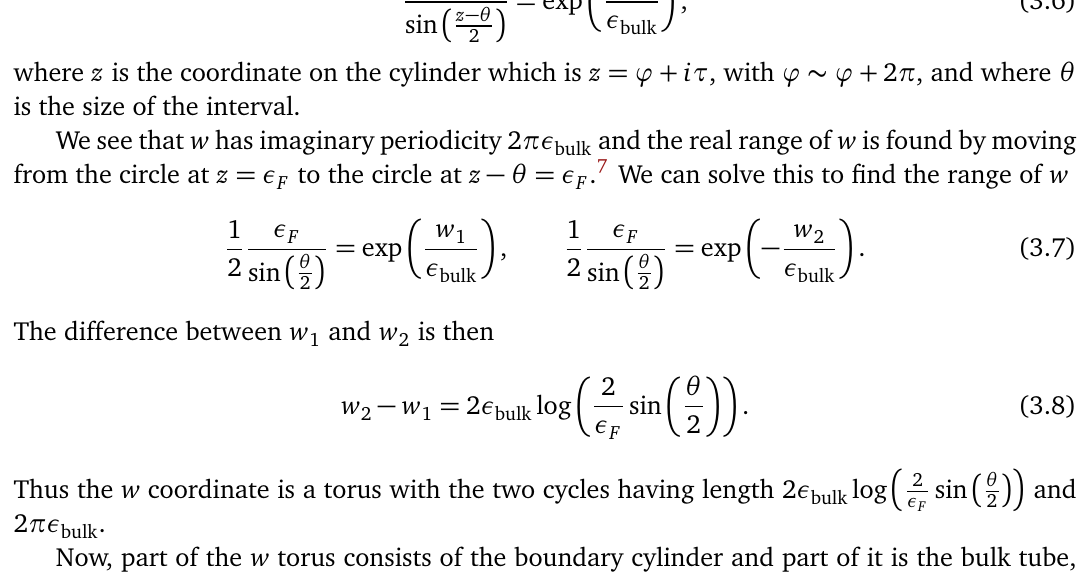
Figure 4: The bulk geometry in the z -plane. The two red circles with radius ε identified, whereas the black circles of radius ε distance between the two circles is θ , the size of the interval on the boundary. Once glued together the region in between the two black circles represents the bulk tube around the entanglement